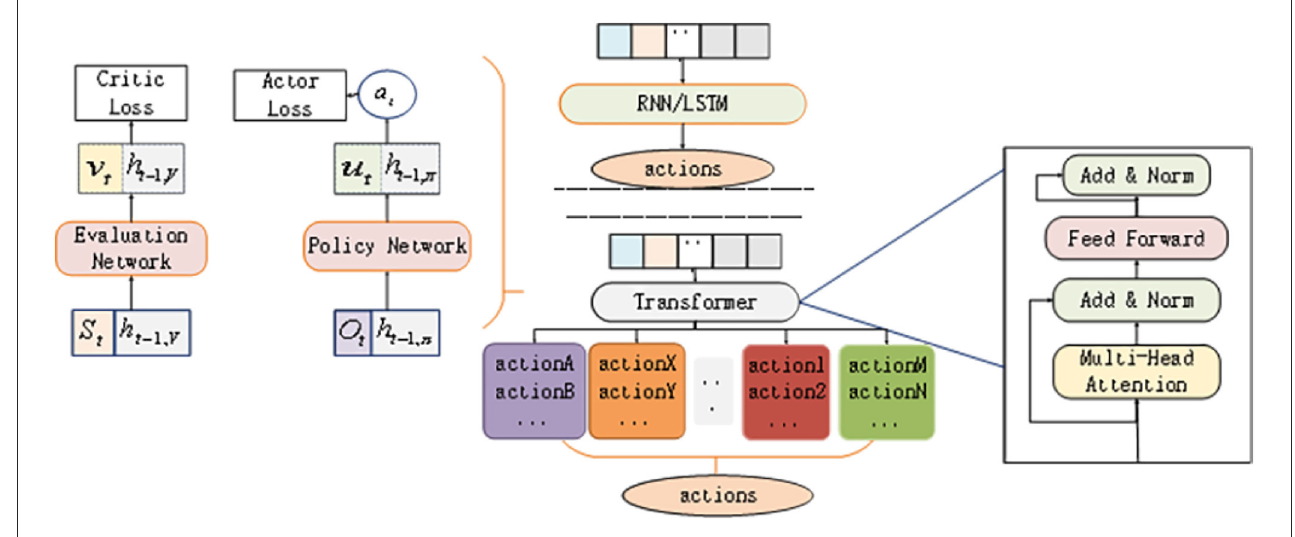
FIGURE2 Trans-UTPA algorithm framework.